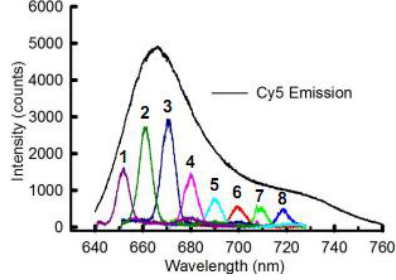
FIGURE 3: Cy5 emission spectrum and levels of Cy5 fluorescence detected in different output channels